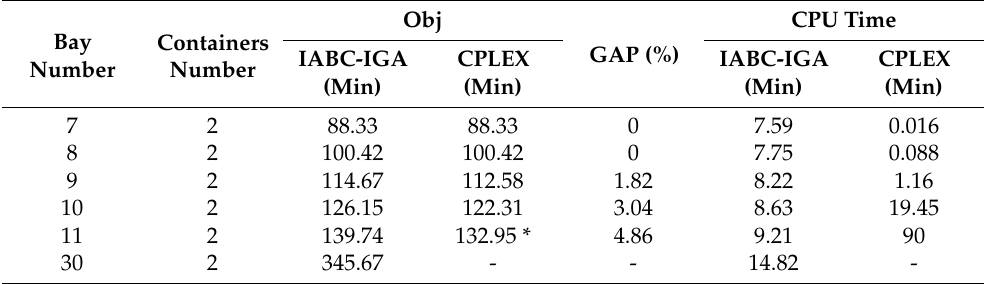
Table 5. Solution quality of IABC-IGA and CPLEX.